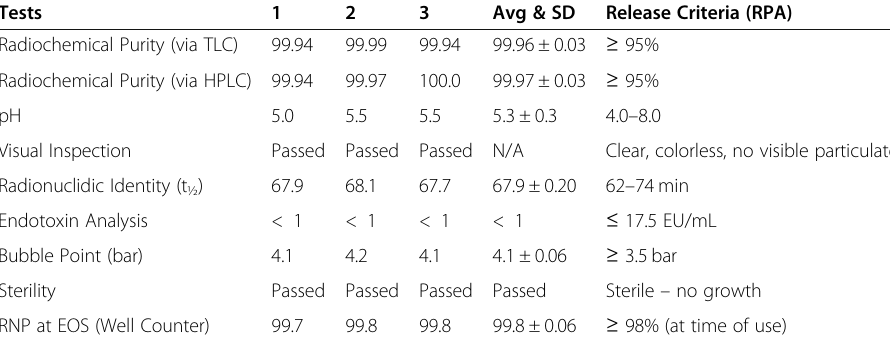
Table 9 Quality Control Data for three [ 68 Ga]Ga-PSMA-11 validation runs (RPA)